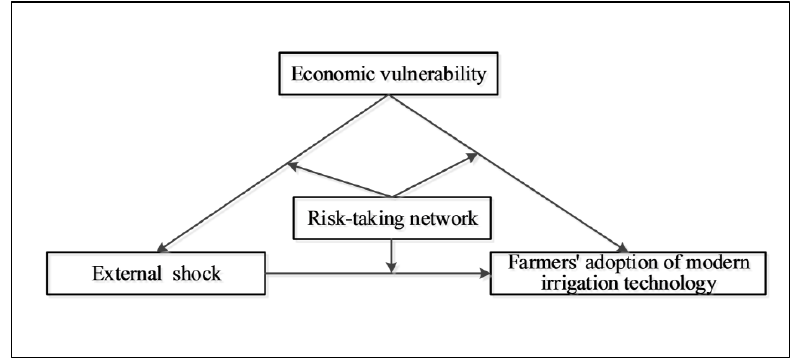
Figure 1. Theoretical model of the study.